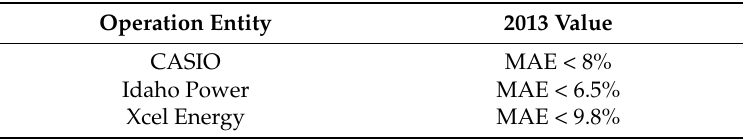
Table 5. Assessments of forecasting